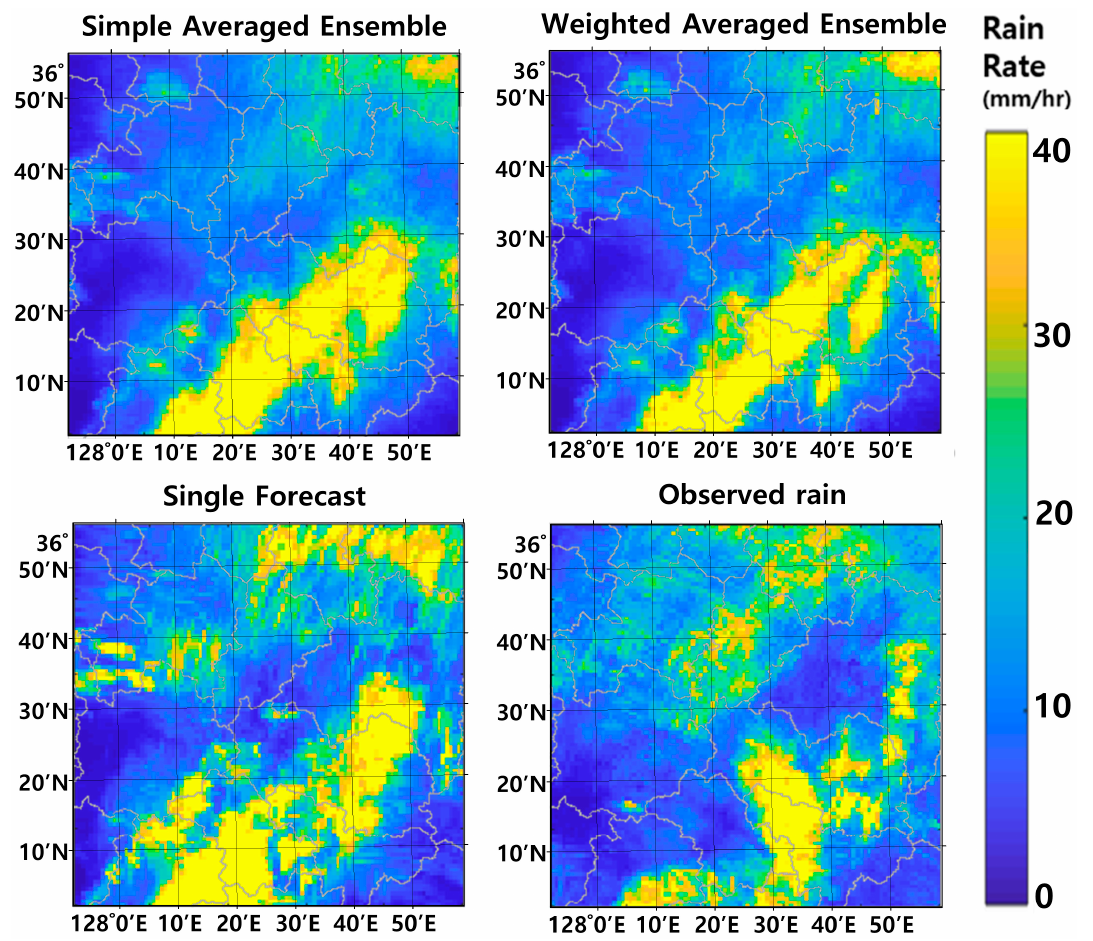
Figure 8. Comparison of the ensemble forecast based on the weighted averaging with the ensemble forecast based on the simple arithmetic average method, for the single forecast and the observed at 09:00 8 July 2017.